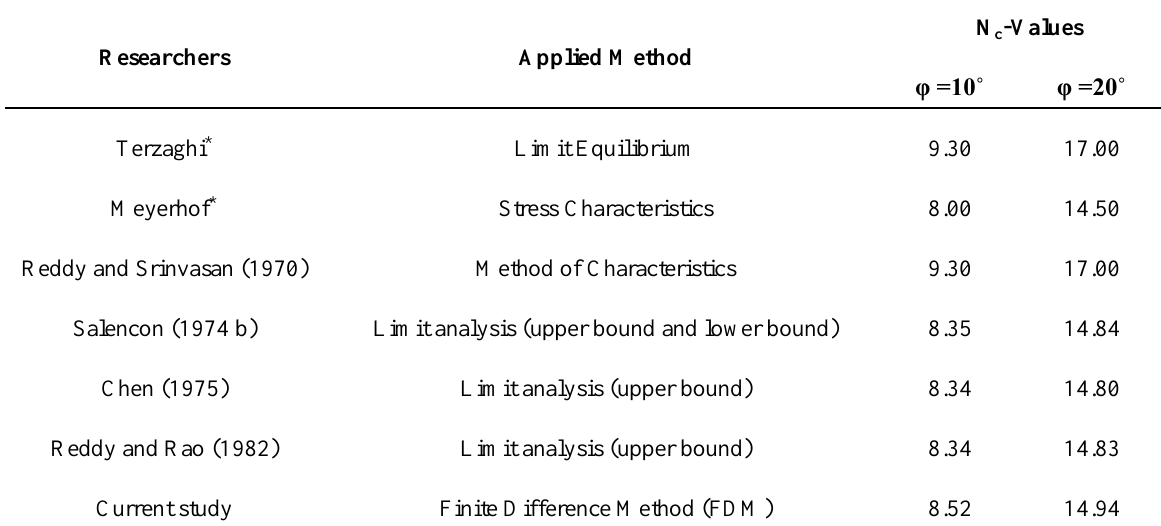
–values for G=0.0 and ν=0.0. C